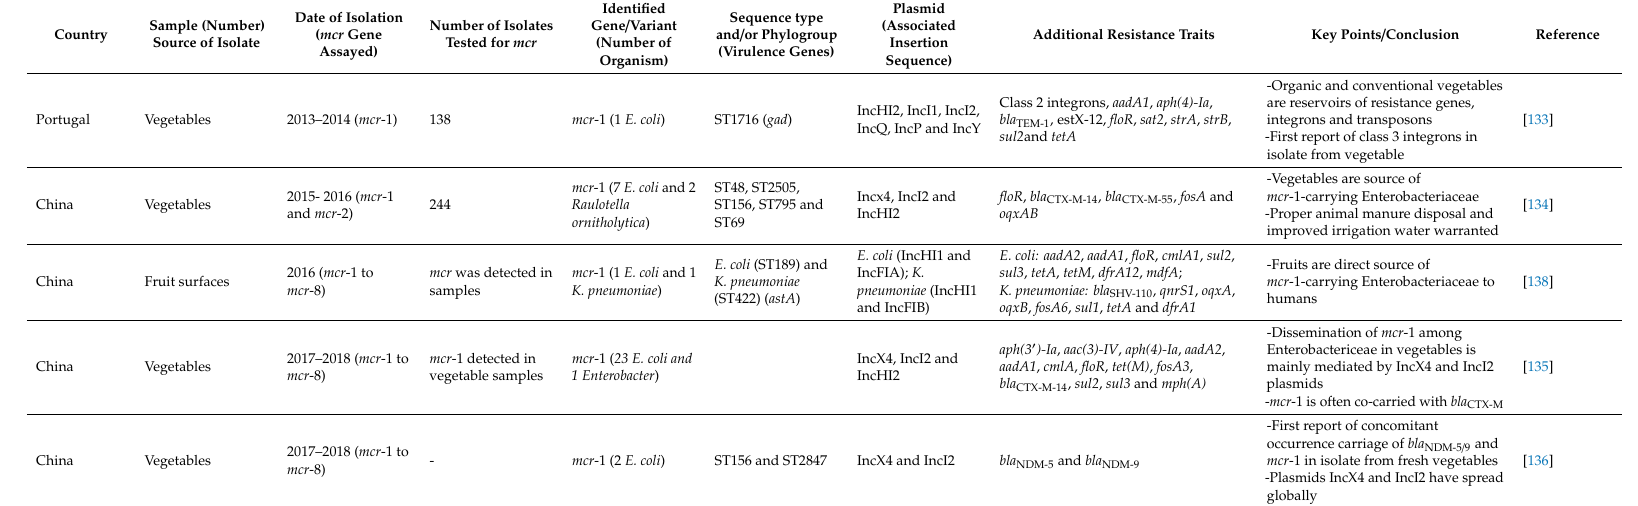
Table 6. Studies reporting plasmid-mediated colistin resistance in botanical ecosystems.